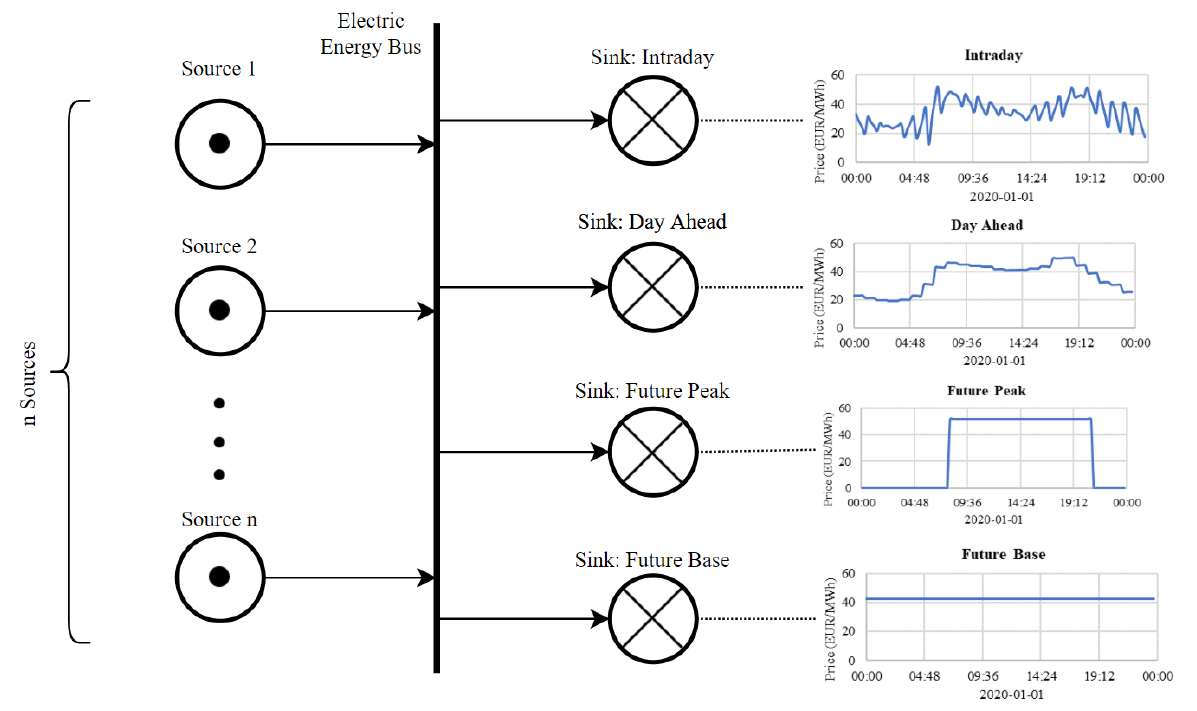
Figure 2. Overview of the model structure representing one or several power plants and different simultaneous